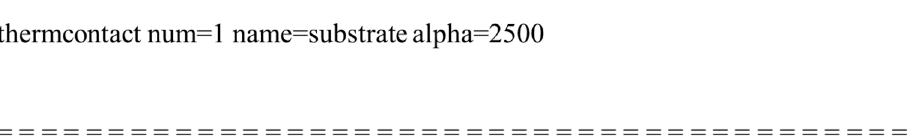
Figure 2. Physical models and parameters used in simulation code.